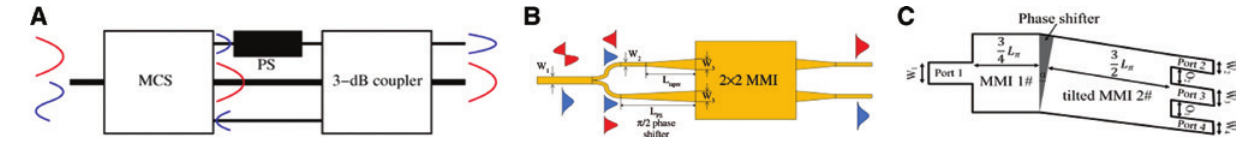
Figure 2: Examples of the MMI-based mode (de)multiplexer. (A) A two-channel MMI-based mode (de)multiplexer consisting of an MCS, a butterfly-shape tapered PS, and a 3 dB MMI coupler [37]. (B) A two-channel mode (de)multiplexer based on a symmetric Y-junction and MMI waveguide [38]. A two-channel mode (de) multiplexer based on MMI couplers with a tilted joint